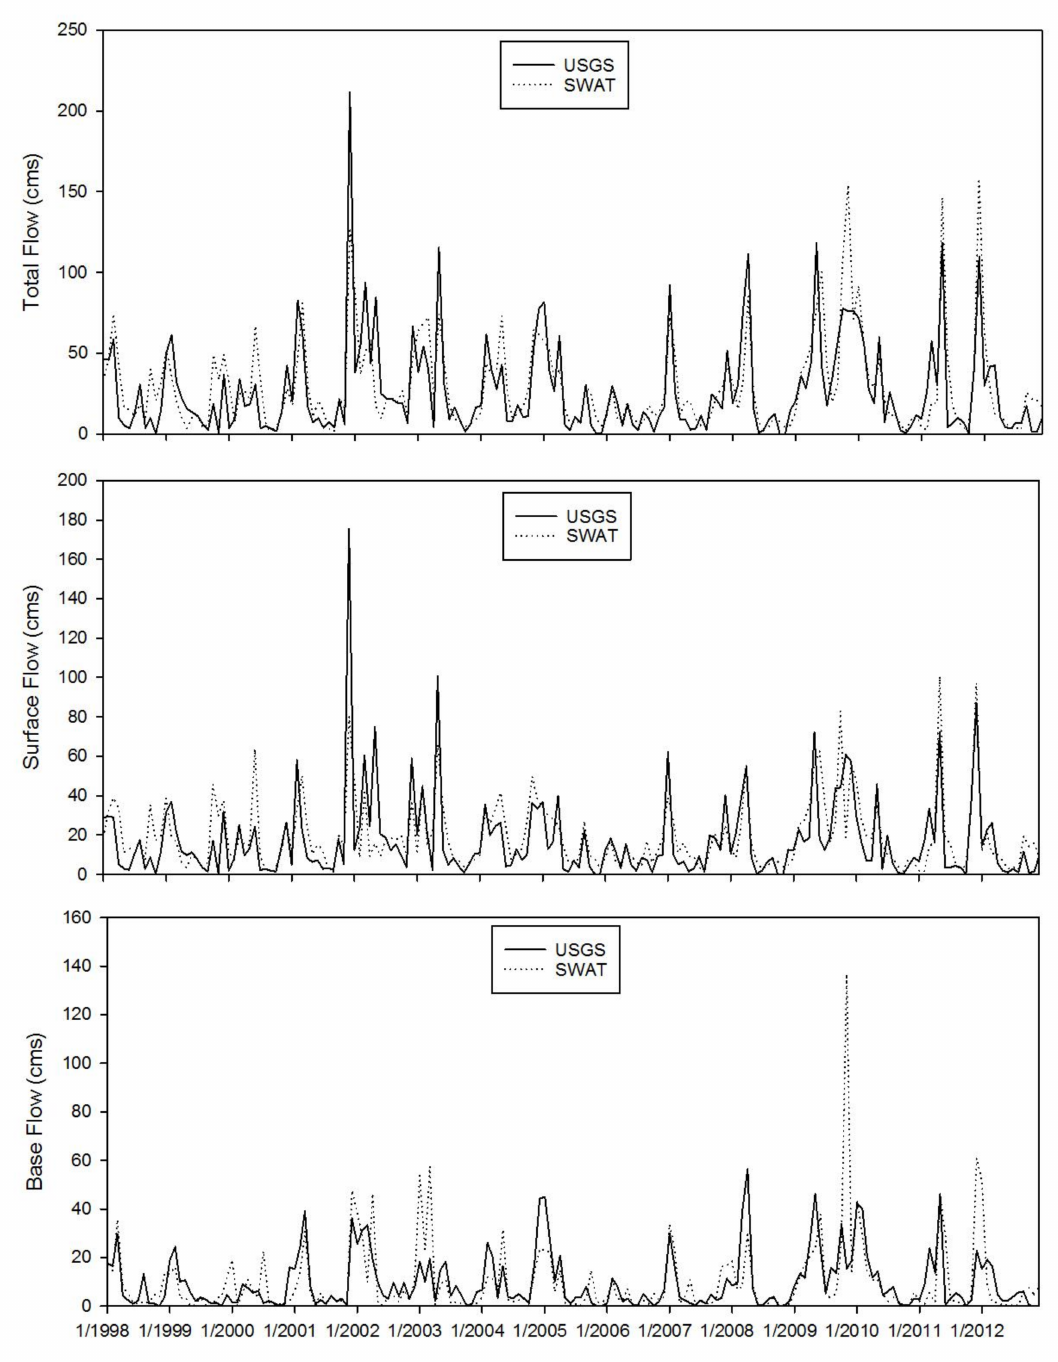
Figure 4. Graphical comparison of the USGS (measured) and SWAT (simulated) flow data at the Palestine